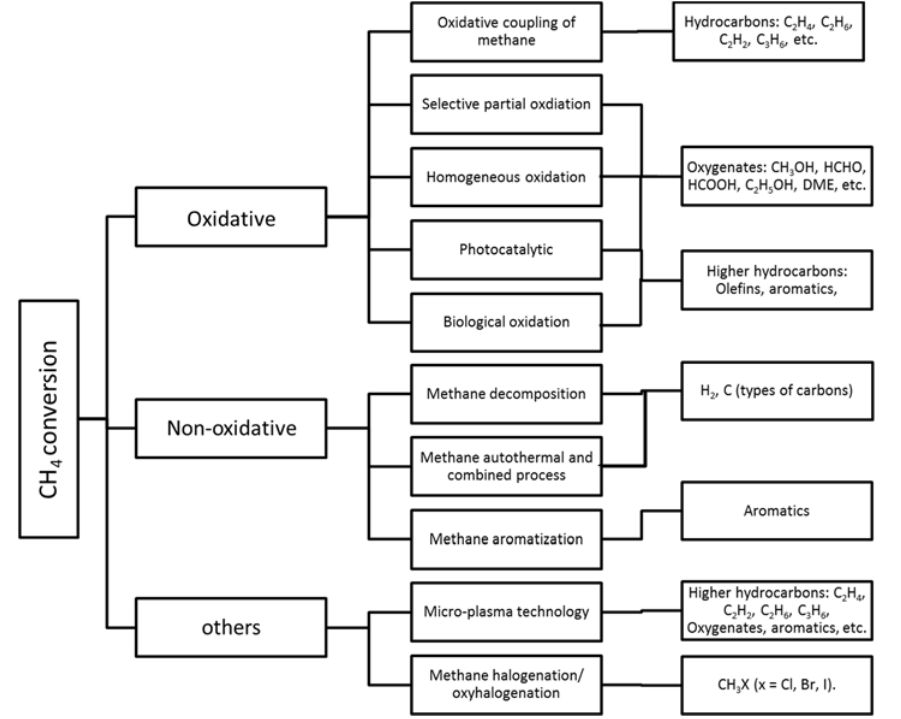
Figure 2. Direct methane conversion technologies to various valuable chemicals, intermediates and fuel